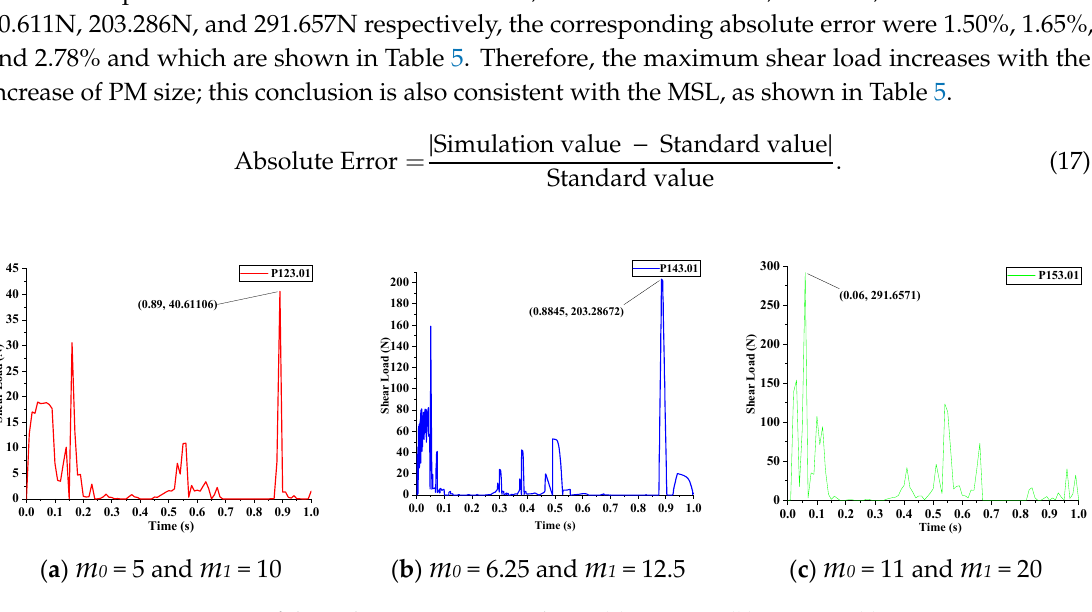
Figure 11. MSL of three shear actuation products: ( a ) P-123.01; ( b ) P-143.01; ( c ) P-153.01.